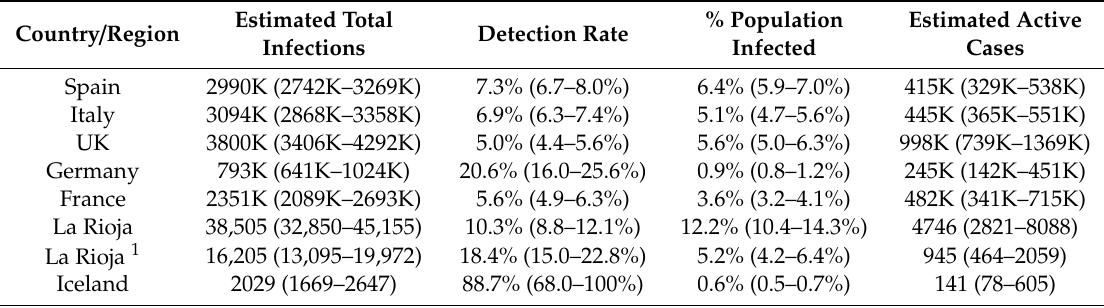
Table 4. Estimated cumulative infections as of 5 May 2020 (shown median values with 95% credible